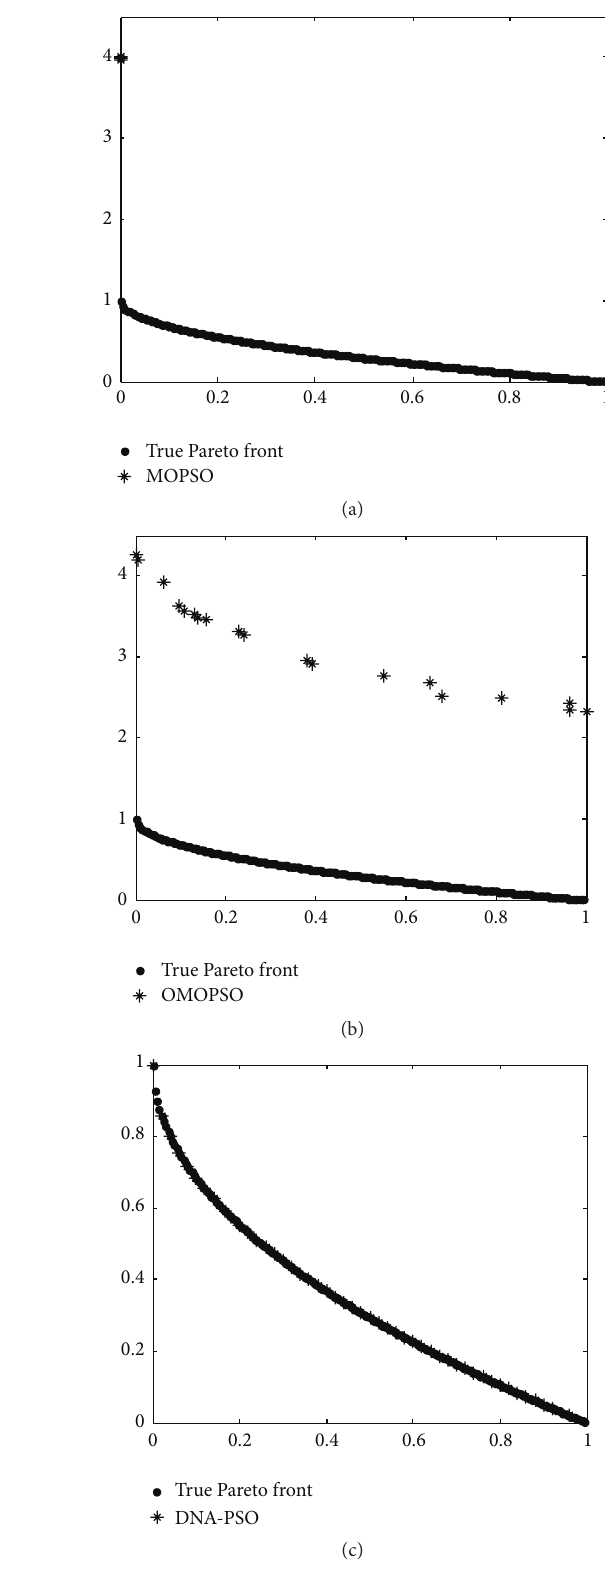
Figure 8: Pareto fronts obtained in test problem ZDT3.